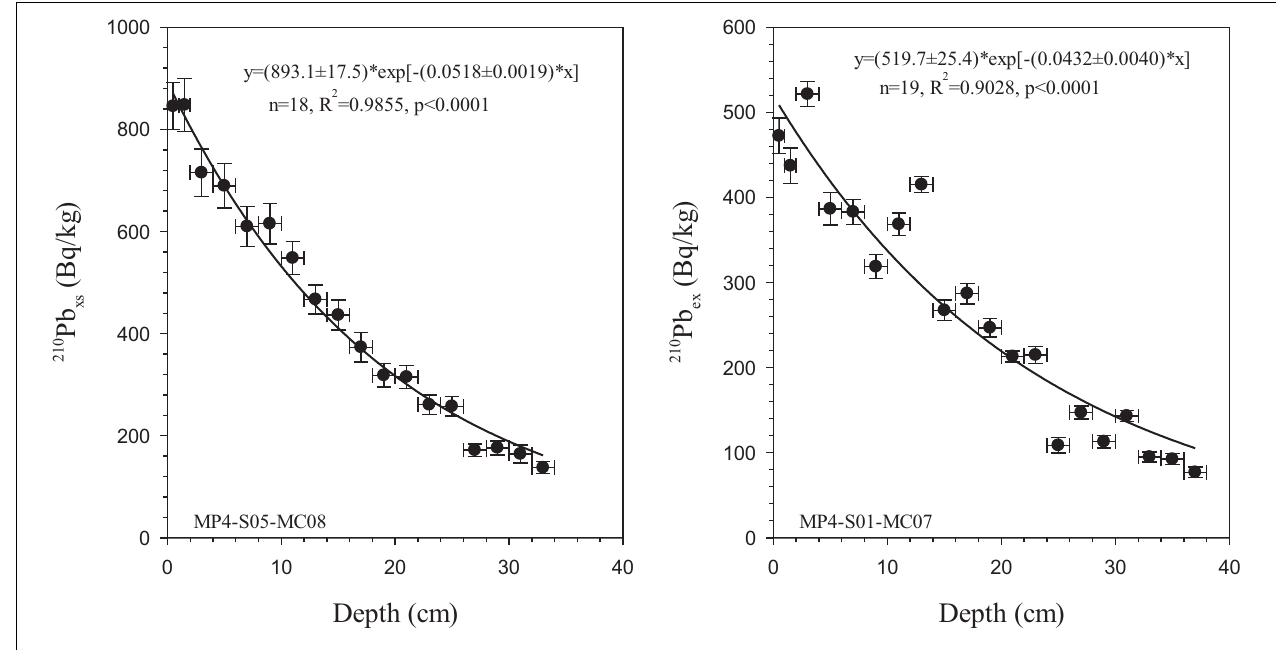
FIGURE 3 | The relationship between specific activity of 210 Pb ex and depth in sediment cores. The fitting curve and equation are shown in each panel.